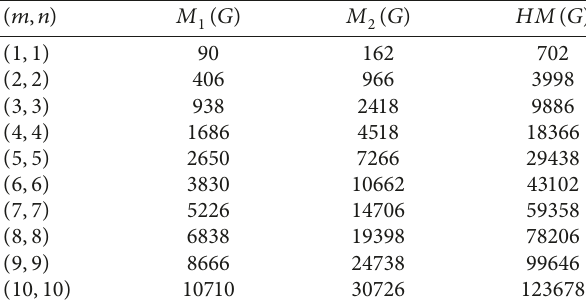
( G ) , M ( G ) , and HM ( G ) . 1 2